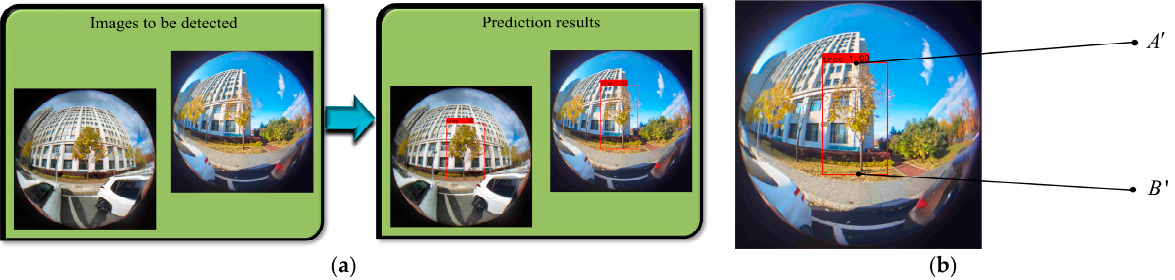
Figure 11. Tree detection and tree extreme point extraction. ( a ) Fisheye image of detection tree; ( b ) Extract extreme points .